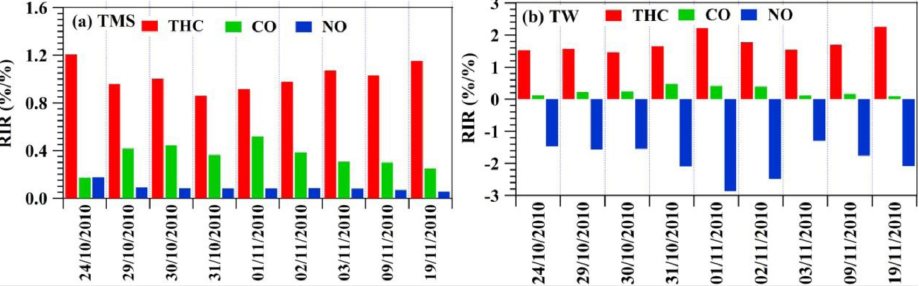
Fig. 13. RIR values of O 3 precursors, i.e., THC (total hydrocarbons, consist of the VOCs described in Sect. 3.2.1), NO and CO at (a) TMS and (b)